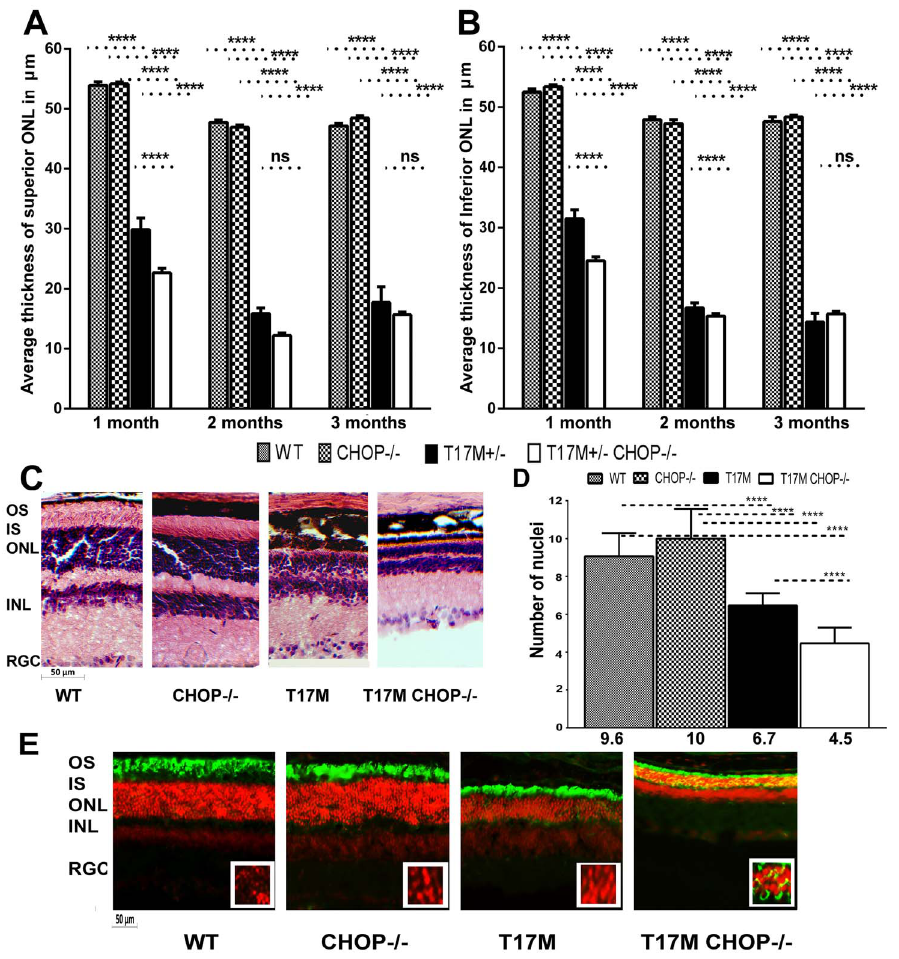
Figure 2. Retinal structure measured by SD-OCT was altered in the T17M RHO CHOP 2 / 2 retina. We analyzed 4 groups of animals (N=6) by two-way ANOVA and found significant changes in the average thickness of the ONL in the inferior and superior hemispheres in 1,2 and 3-month- old mice. A: In the superior region, the average thickness of the ONL was 53.89 m m 6 0.8 in wild-type, vs. 54.2 m m 6 0.2 in CHOP 2 / 2 mice. A dramatic reduction of 22% in the ONL thickness was observed between the T17M RHO and T17M RHO CHOP 2 / 2 retinas (29.88 m m 6 0.3 in T17M RHO vs. 23.7 m m 6 0.3 in T17M RHO CHOP 2 / 2 ), which was statistically significant ( P , 0.001). The differences between wild-type and T17M RHO or T17M RHO CHOP 2 / 2 and CHOP 2 / 2 and T17M RHO or T17M RHO CHOP 2 / 2 were also statistically significant ( P , 0.0001). No difference in the thickness of the superior ONL was observed when wild-type and CHOP 2 / 2 retinas were compared. At 2 months, the ONL thickness in the T17M RHO retina continued to decline and was 15.83 m m 6 0.95 in T17M RHO vs. 12.19 m m 6 0.43 in T17M RHO CHOP 2 / 2 ), which was not statistically significant. In wild- type animals, the ONL thickness was 47.8 m m 6 0.38 vs 46.92 m m 6 0.37 in CHOP 2 / 2 mice. The differences between wild-type and T17M RHO or T17M RHO CHOP 2 / 2 and CHOP 2 / 2 and T17M RHO or T17M RHO CHOP 2 / 2 were also statistically significant ( P , 0.0001). No difference in the thickness of the superior ONL was observed when wild-type and CHOP 2 / 2 retinas were compared. At 3 months of age, the ONL thickness in the T17M RHO retina was 17.72 m m 6 2.59 in T17M RHO vs. 15.68 m m 6 0.43 in T17M RHO CHOP 2 / 2 ), which was not statistically significant. In wild- type animals, the ONL thickness was 47.15 m m 6 0.44 vs 48.47 m m 6 0.37 in CHOP 2 / 2 mice. The differences between wild-type and T17M RHO or T17M RHO CHOP 2 / 2 and CHOP 2 / 2 and T17M RHO or T17M RHO CHOP 2 / 2 were also statistically significant ( P , 0.0001). No difference in the thickness of the superior ONL was observed when wild-type and CHOP 2 / 2 retinas were compared. B: The average thickness of the inferior ONL was also measured in the 4 groups of mice. We found that the average thickness was 52.5 m m 6 0.51 in wild-type; 53.4 m m 6 0.3 in CHOP 2 / 2 mice vs. 31.5 m m 6 0.2 in T17M RHO ; and 24.5 m m 6 0.4 in T17M RHO CHOP 2 / 2 . The differences between wild-type and T17M RHO or T17M RHO CHOP 2 / 2 and CHOP 2 / 2 and T17M RHO or T17M RHO CHOP 2 / 2 were statistically significant ( P , 0.0001). The difference (24%) between T17M RHO and T17M RHO CHOP 2 / 2 was also statistically significant ( P , 0.001). No difference in the thickness of the inferior ONL was observed when wild-type and CHOP 2 / 2 retinas were compared. The average inferior ONL thickness in 2 month-old animals was different in all groups and was 48.0 m m 6 0.46 in wild-type; 47.3 m m 6 0.75 in CHOP 2 / 2 mice vs. 16.7 m m 6 0.8 in T17M RHO ; and 15.4 m m 6 0.4 in T17M RHO CHOP 2 / 2 . The differences between wild-type and T17M RHO or T17M RHO CHOP 2 / 2 and CHOP 2 / 2 and T17M RHO or T17M RHO CHOP 2 / 2 were statistically significant ( P , 0.0001). The difference between T17M RHO and T17M RHO CHOP 2 / 2 was also statistically significant ( P , 0.001). No difference in the thickness of the inferior ONL was observed when wild-type and CHOP 2 / 2 retinas were compared. At 3 months of age the difference in the average inferior ONL thickness was not significant between T17M RHO and T17M RHO CHOP 2 / 2 mice (14.4 m m 6 0.8 in T17M RHO vs 15.6 m m 6 0.4 in T17M RHO CHOP 2 / 2 ) while differences between wild-type (47.6 m m 6 0.8) and T17M RHO or T17M RHO CHOP 2 / 2 and CHOP 2 / 2 (48.4 m m 6 0.3) and T17M RHO or T17M RHO CHOP 2 / 2 were statistically significant ( P , 0.0001). No difference in the thickness of the inferior ONL was observed when wild-type and CHOP 2 / 2 retinas are compared. C: Histological analyses of wild-type, T17M RHO, T17M RHO CHOP 2 / 2 and CHOP 2 / 2 retinas: Images of wild-type, T17M RHO, T17M RHO CHOP 2 / 2 and CHOP 2 / 2 retinas stained with hematoxylin and eosin (H&E). Four animals in each group were used in this experiment. Histology of experimental mouse retinas at 1 month of age showed loss of photoreceptor cell nuclei, shortening of the outer segments, and general disorganization in the T17M RHO retina. Ablation of the CHOP protein in these retinas, however, led to more rapid retinal degeneration that resulted